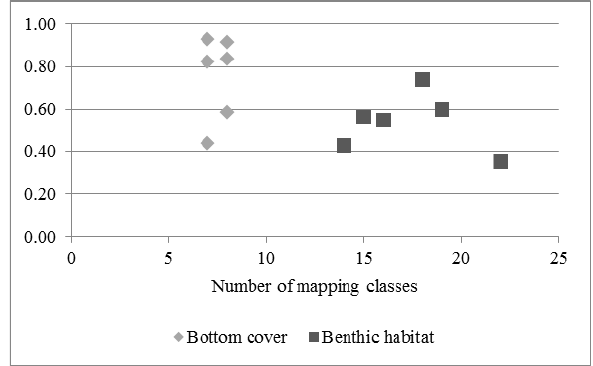
Figure 5. Overall accuracy variation with number of bottom cover and benthic habitat mapping